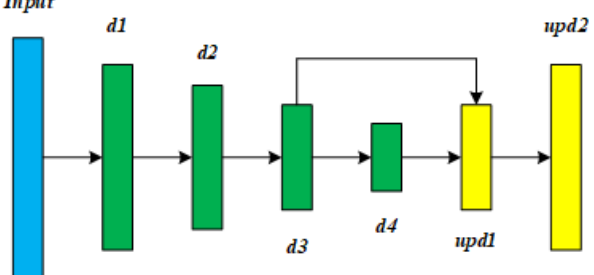
Figure 10. Discriminator architecture.